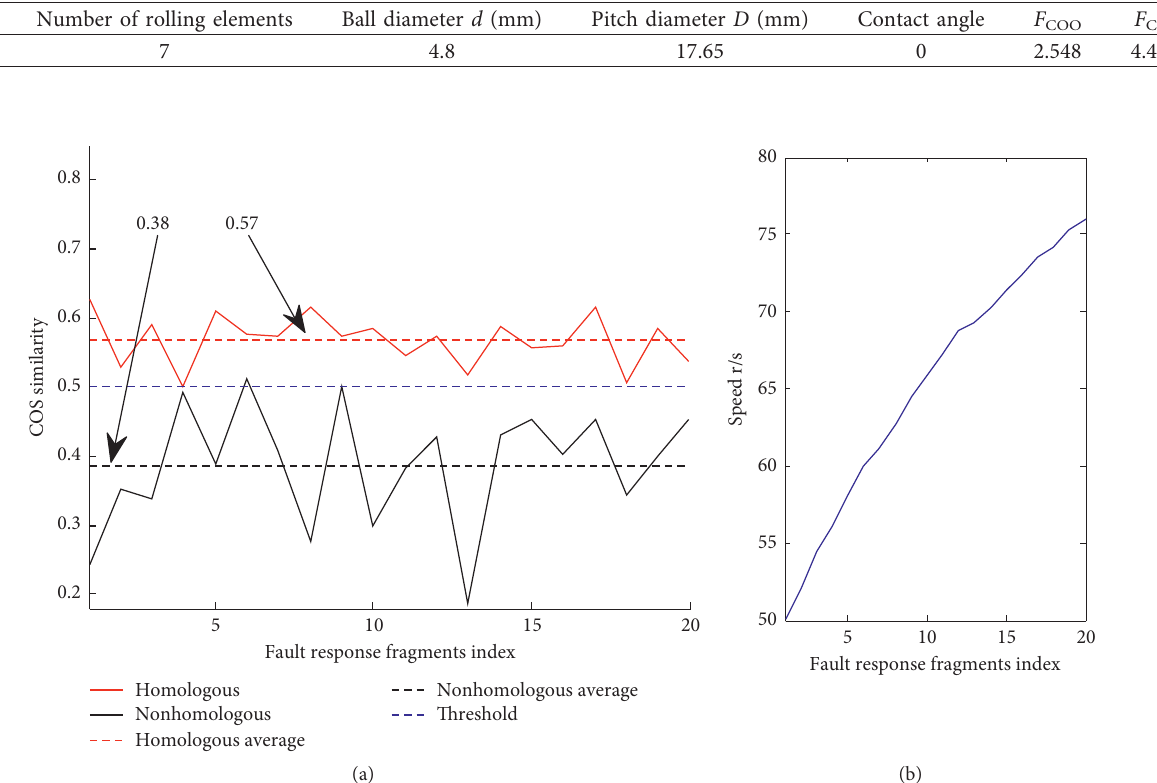
Figure 12: The time-domain waveform of the measured signal. Table 3: The parameters of fault bearing.